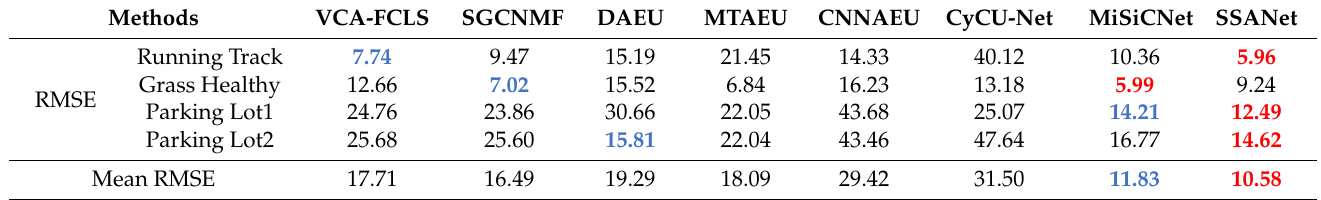
Table 6. RMSE ( × 100) and mean RMSE ( × 100) of abundances acquired by various unmixing approaches on Houston data. Annotation: bold red text indicates the best results and bold blue text indicates the suboptimal